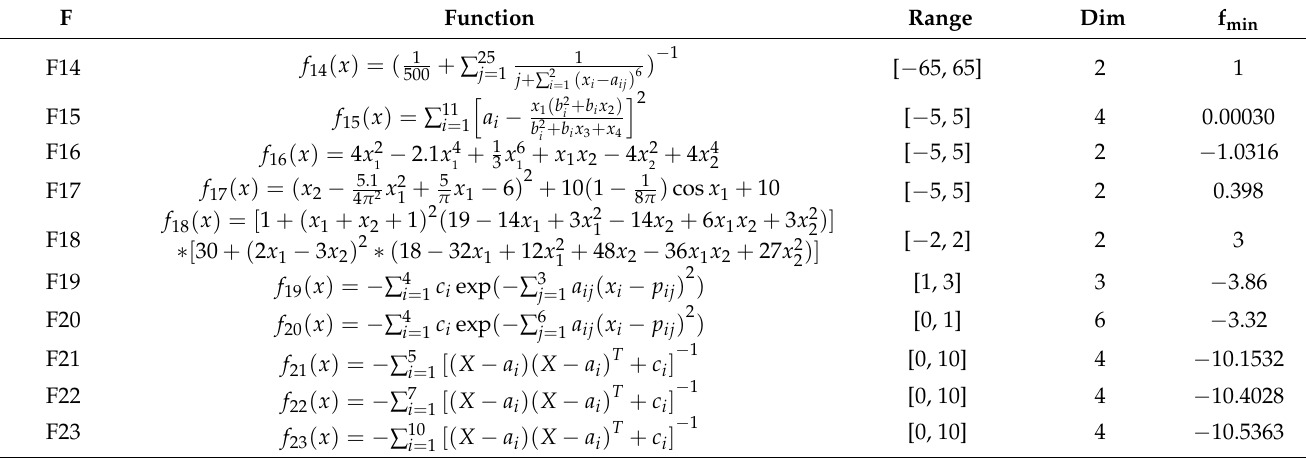
Table 4. Fixed-dimension test